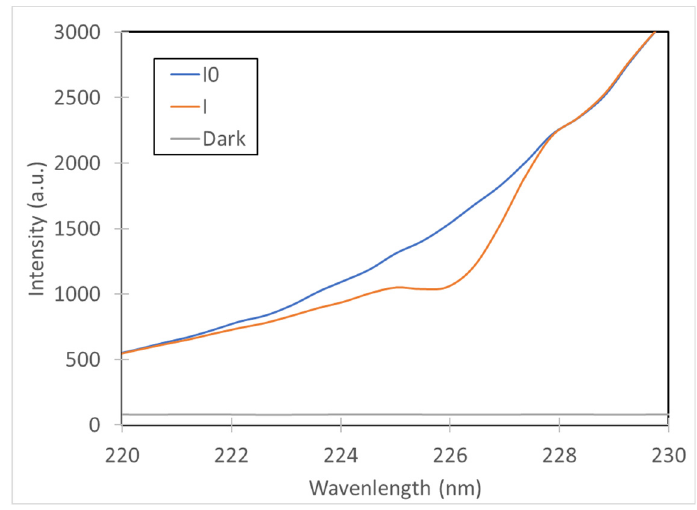
Figure 8. The transmission spectra near 225 nm measured when the process air was heated by Air Plasma gases, I , and when only the process air was in the ECF, I 0 —background signal. The dark current is included in the figure.